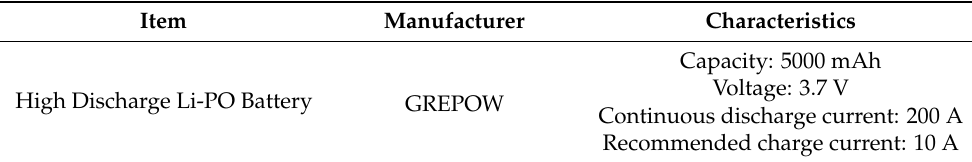
Table 1. Specifications of the parameters of battery